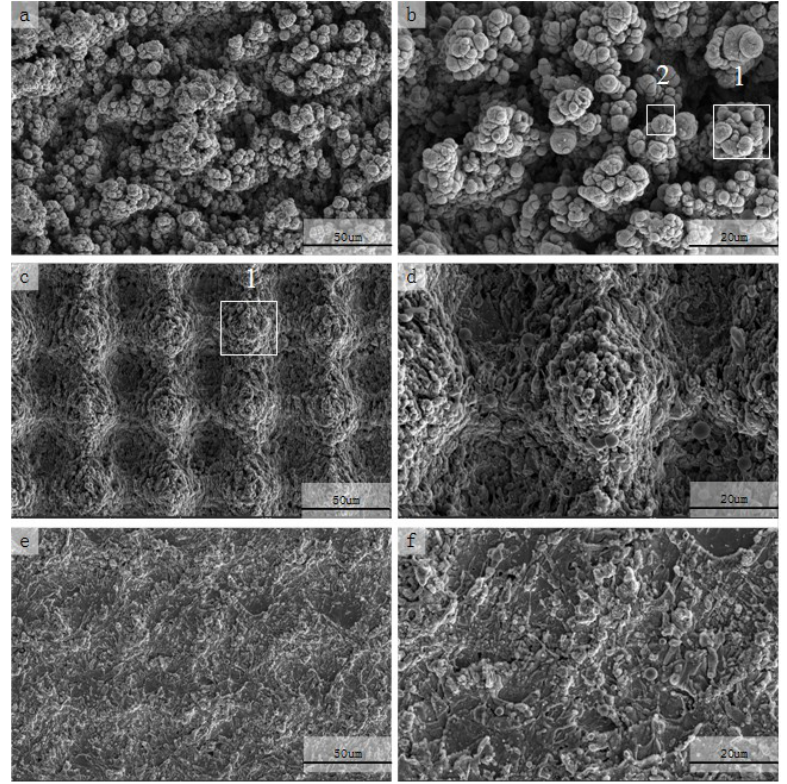
Figure 2. SEM image of copper plate surface after laser ablation and heat treatment: ( a , b ) scanning speed: 100 mm/s, scanning interval: 0.005 mm; ( c , d ) scanning speed: 1300 mm/s, scanning interval: 0.005 mm; ( e , f ) scanning speed: 1300 mm/s, scanning interval: 0.02 mm. 1—nanostructures; 2—slender columnar structures.